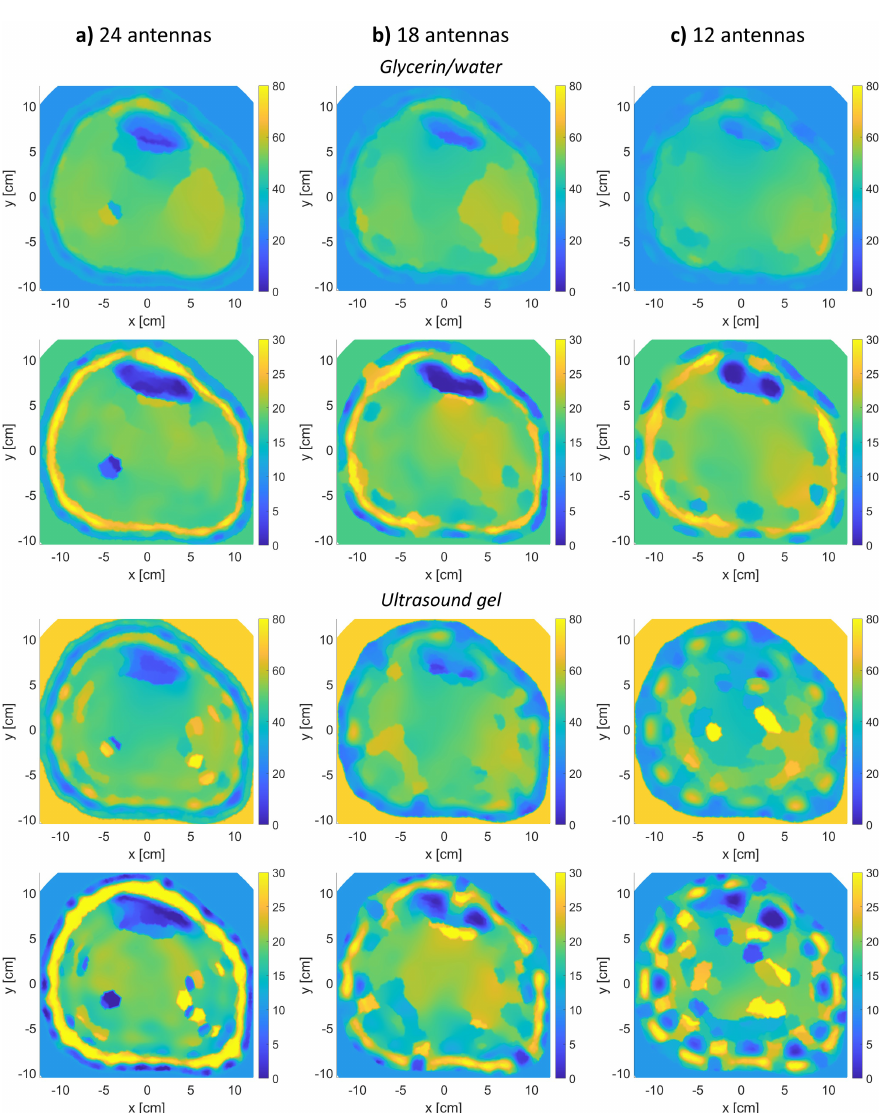
Figure 13. Varying the number of antennas in the reconstruction of leg model 1 using glycerin/water and ultrasound gel matching media: ( a ) twenty-four antennas, ( b ) eighteen antennas, and ( c ) twelve antennas ( top row : real relative permittivity, bottom row : imaginary relative